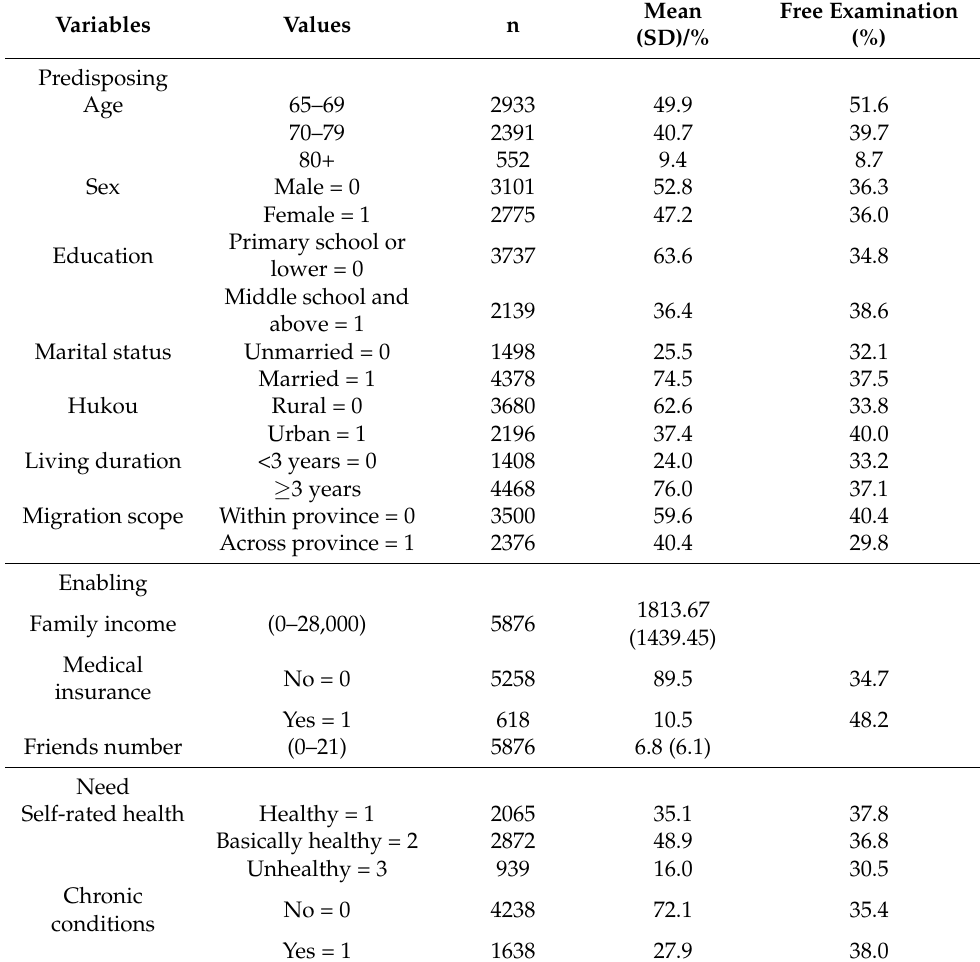
Table 2. Individual and contextual variables, and the associations with free examinations.